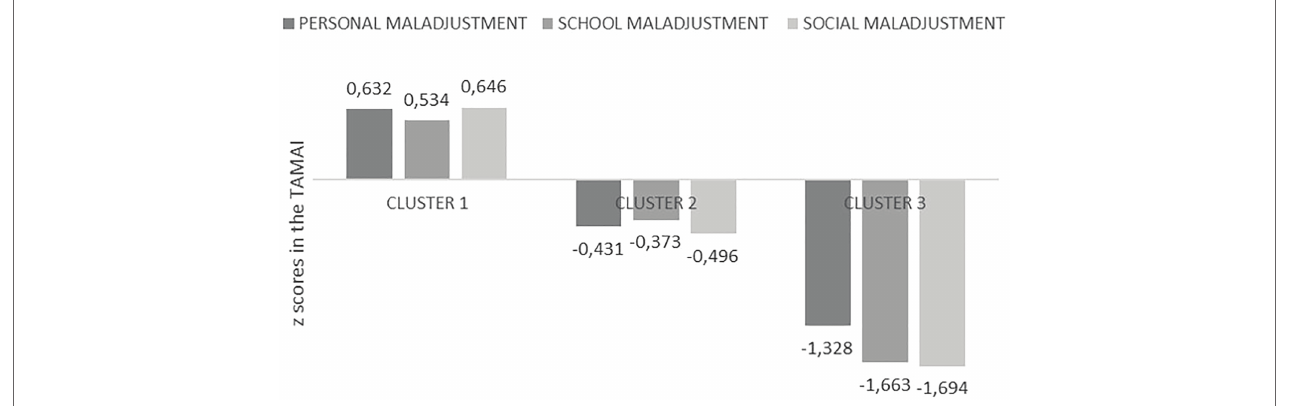
FIGURE 1 | Graphical representation of the three-cluster model.